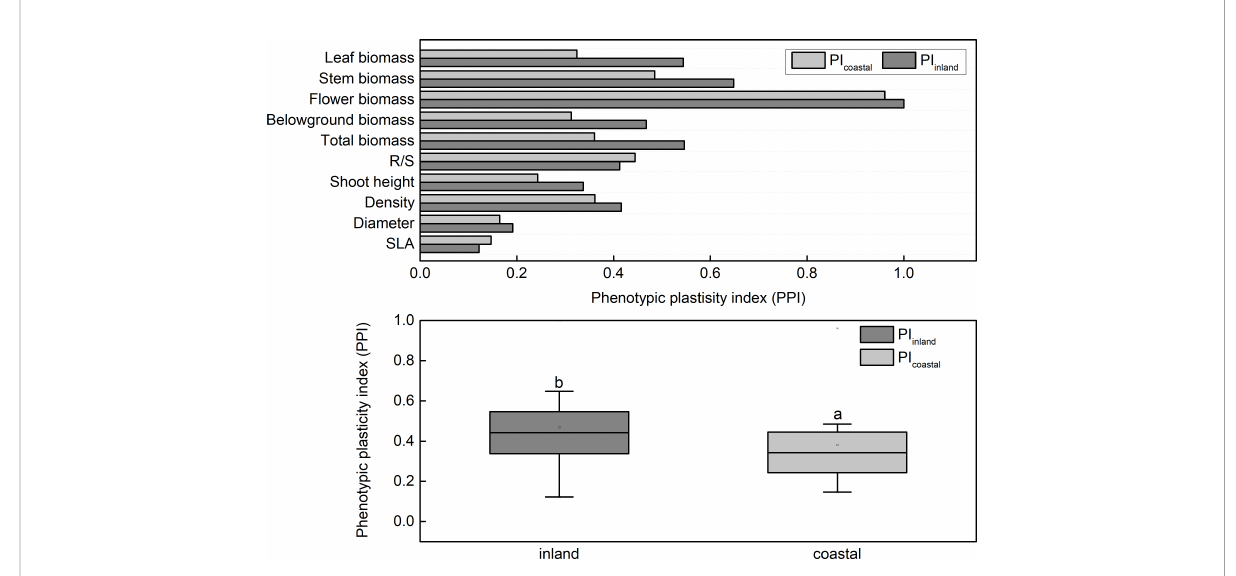
FIGURE 5 Phenotypic plasticity index (PPI) of Phragmites australis populations grown with salt and DNA demethylation